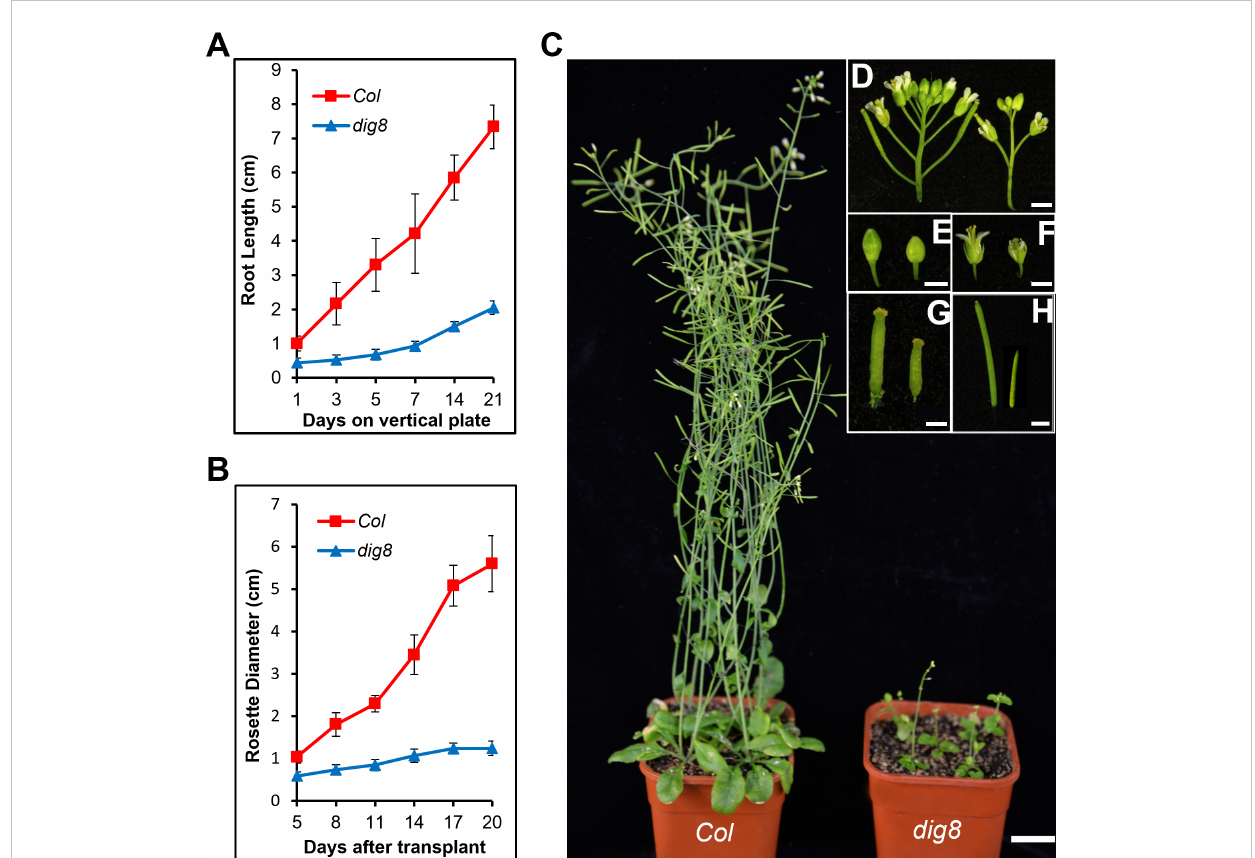
FIGURE 2 Retarded growth of the dig8 mutant. (A) , Root growth rates of Col and dig8 mutant on a vertical plate. 10-day-old seedlings were transferred to a vertically placed plate and root length was recorded daily for 3 weeks. Error bars represent SD (n=20). (B) , Growth rate measured daily by rosette diameters. Error bars represent SD (n=20). (C) , Phenotypes of Col and dig8 mutant adult plants. Scale bar, 2 cm. (D – H) , Enlarged view of fl owers and siliques of Col (on the left) and dig8 mutant (on the right). (D) , in fl orescences; (E) , fl ower buds; (F) , pollinated fl owers; (G) , developing siliques; (H) , siliques. Scale bars, 0.2